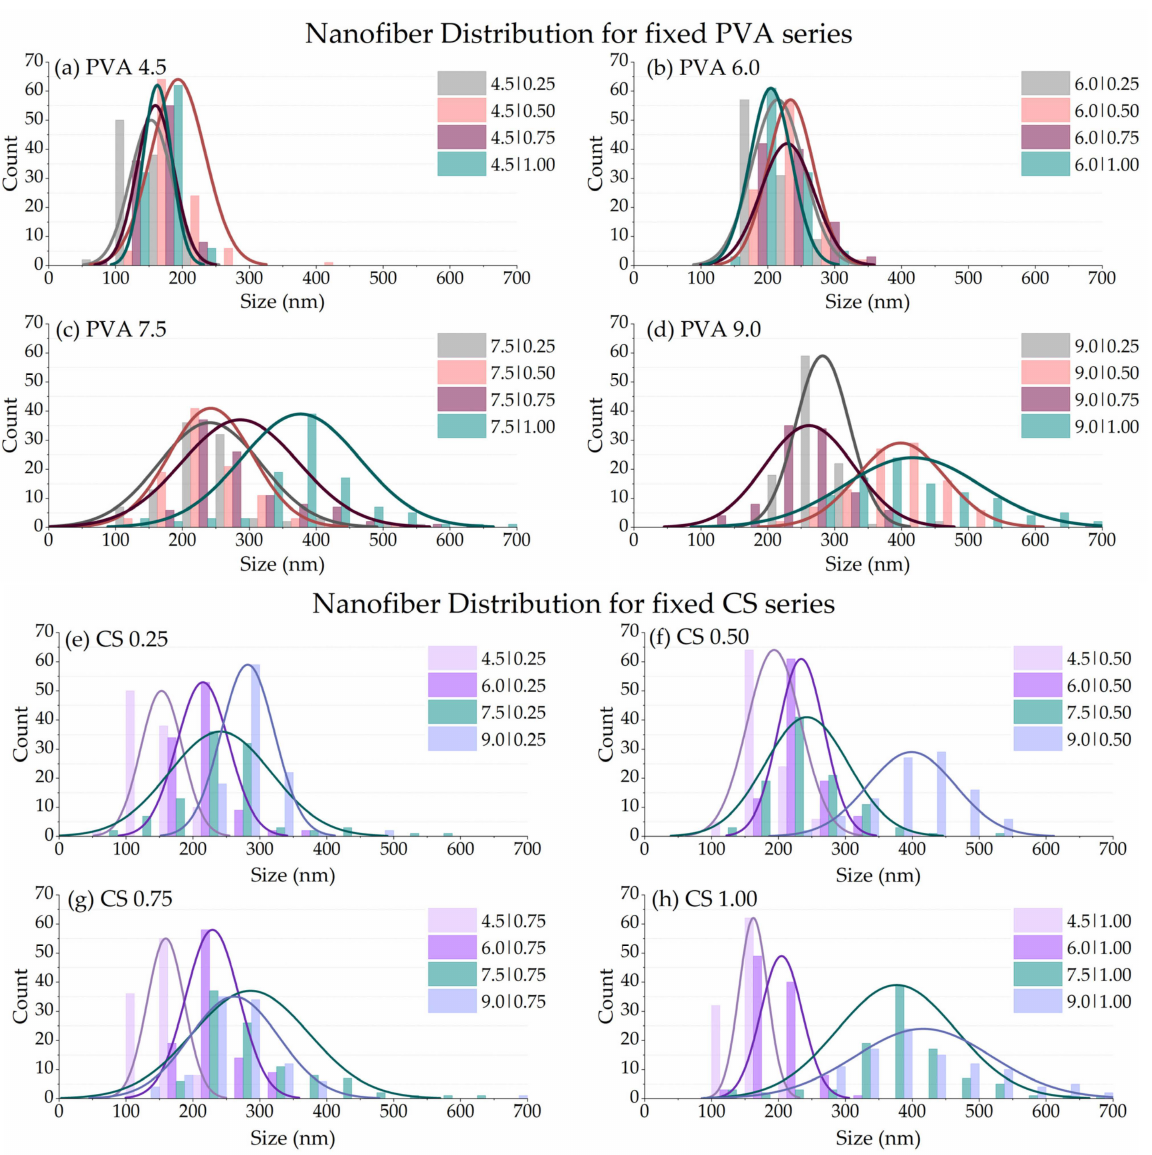
Figure 7. Fiber size distribution for samples with fixed PVA content series: ( a ) 4.5; ( b ) 6.0; ( c ) 7.5, and ( d ) 9.0% w / w . Fiber size distribution for the series with fixed CS at: ( e ) 0.25; ( f ) 0.50; ( g ) 0.75, and ( h ) CS